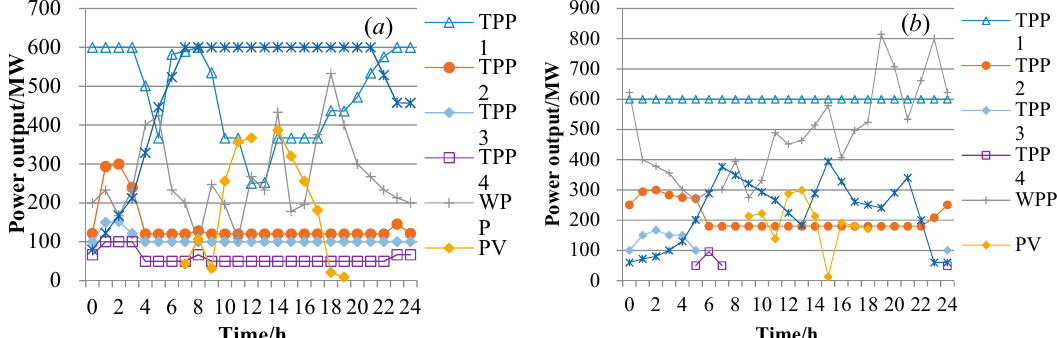
Figure 13. The scheduling results of the MECS operation without ESD on a typical day: ( a ) summer and ( b ) winter.